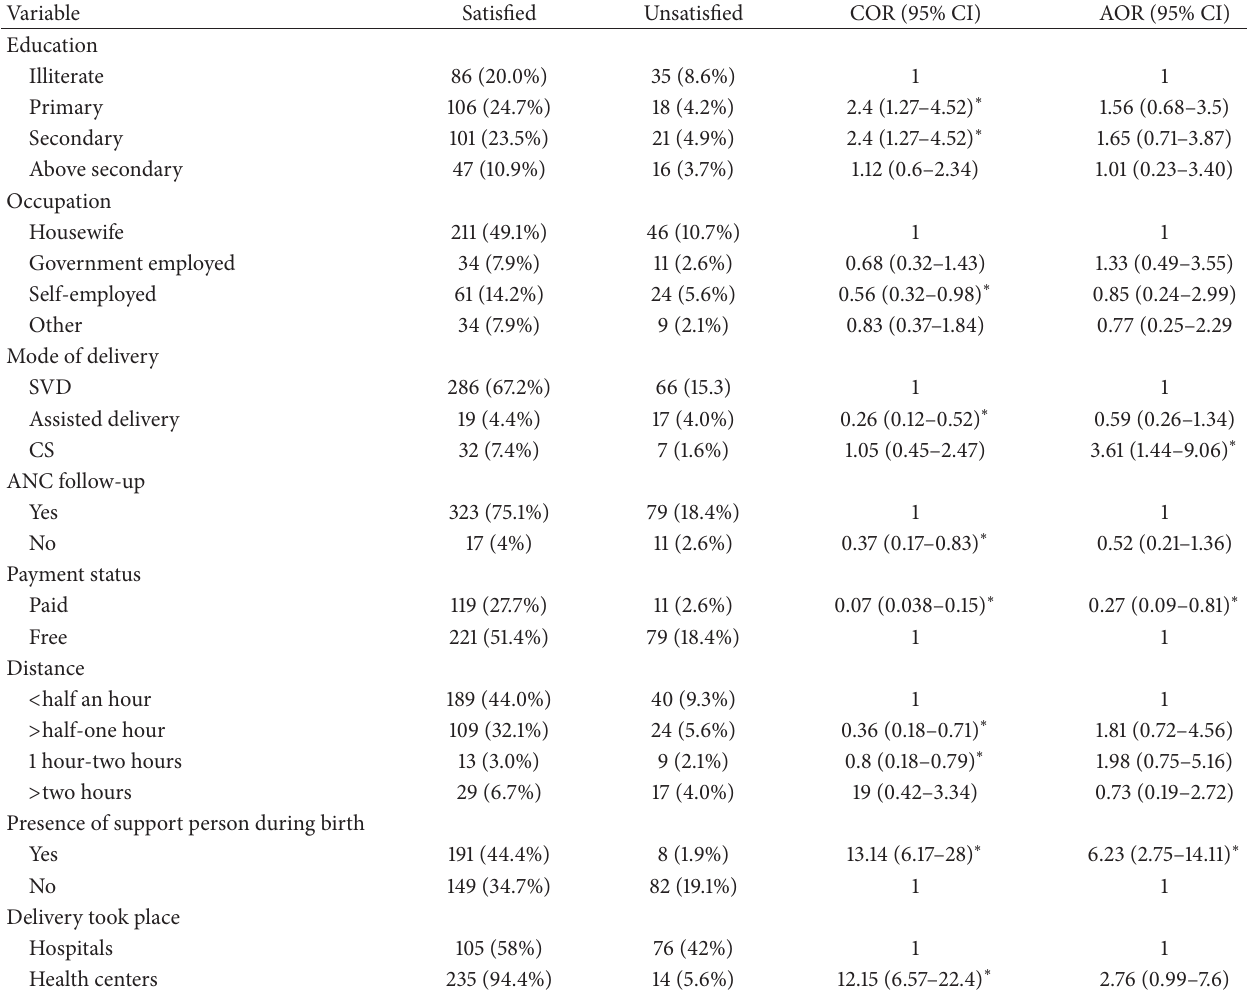
Table 3: Predictors of satisfaction in public health facility of Gamo Gofa Zone, southwest Ethiopia, May 2014 ( 𝑛 = 430